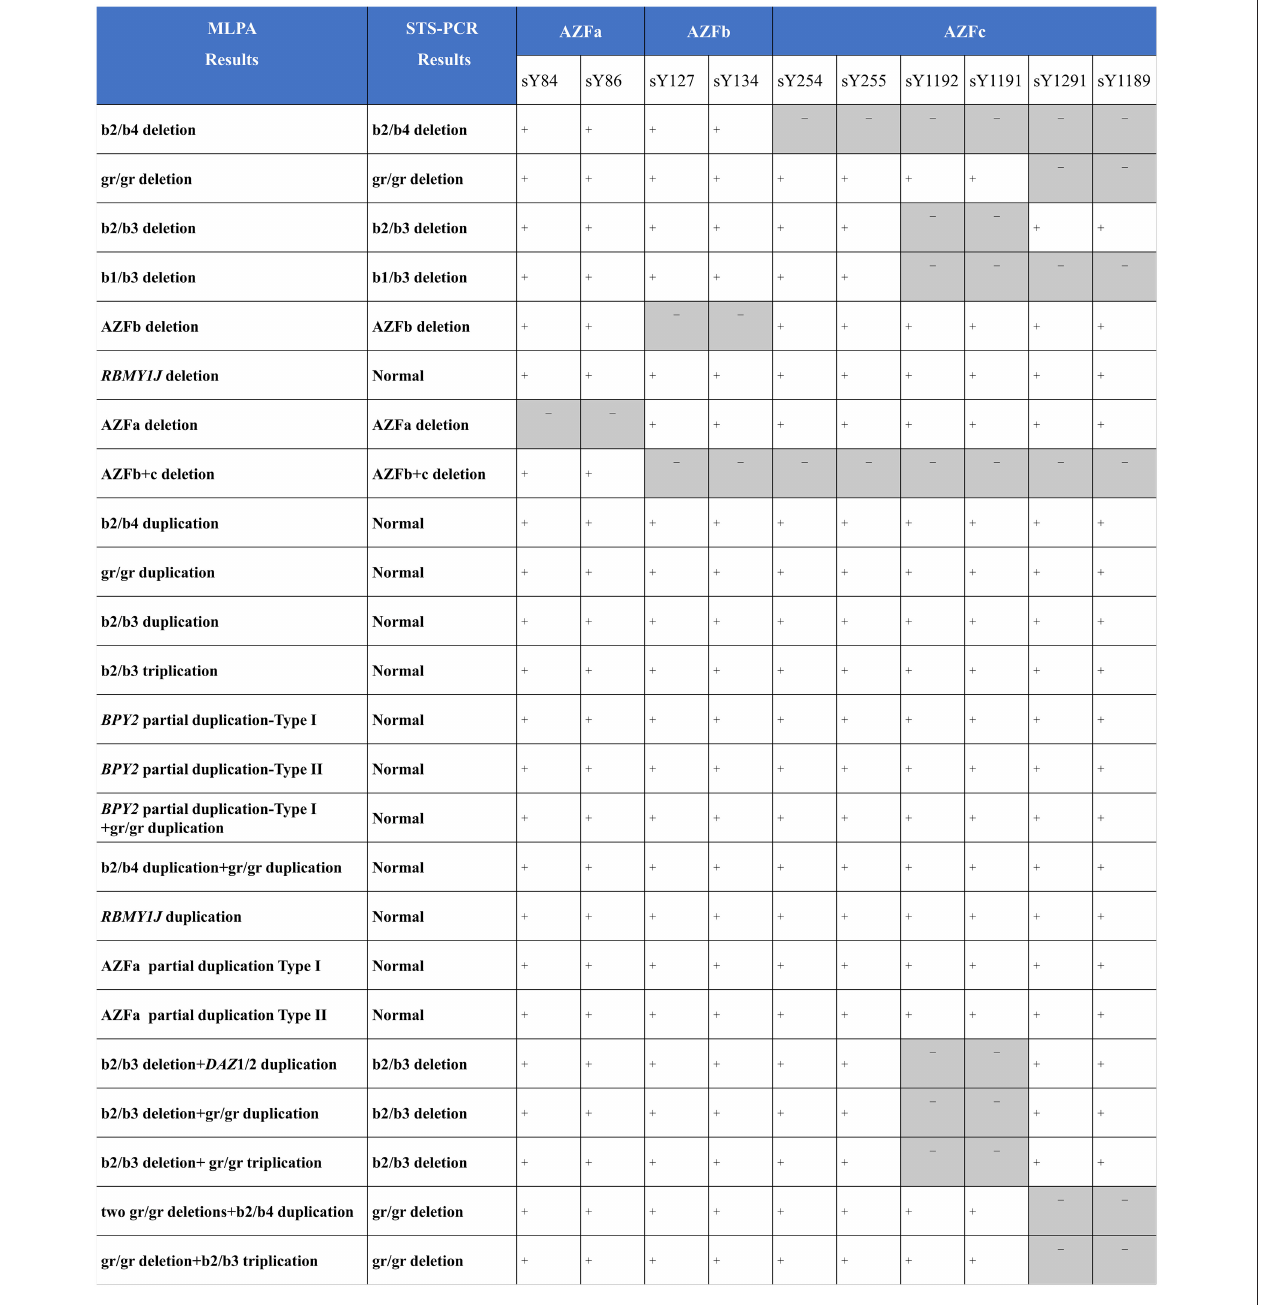
FIGURE 4 | Comparing MLPA methods with traditional agarose electrophoresis for STS markers. + , the fragment in the STS site was not deleted; -, the fragment in the STS site was